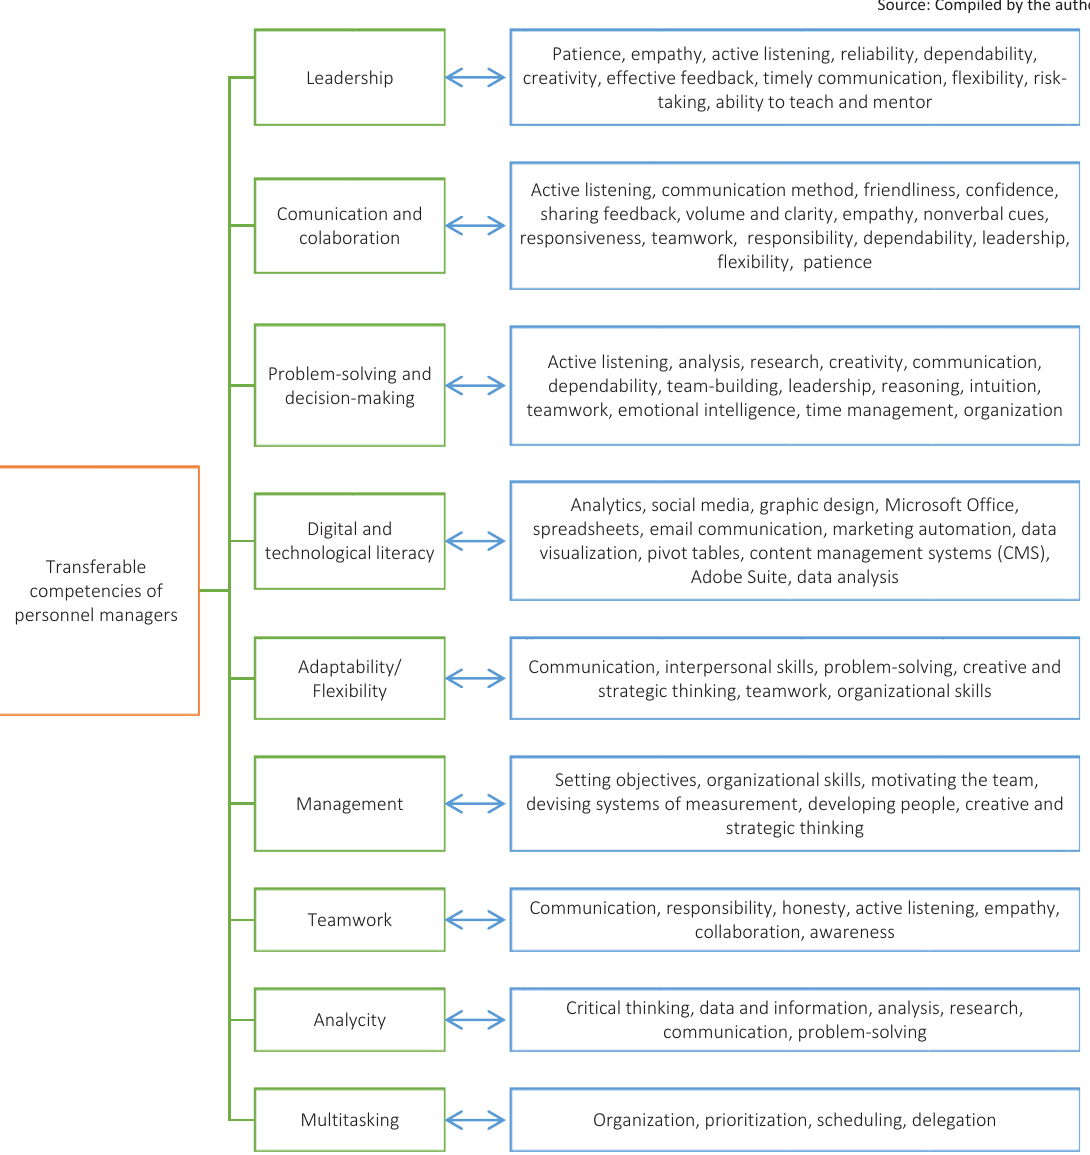
Figure 3. Interrelated transferable competencies for HR